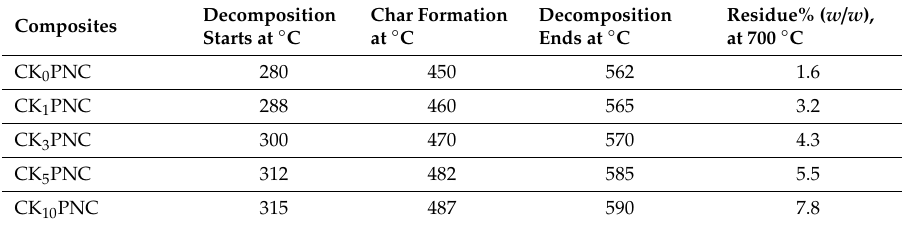
Table 2. Thermogravimetric profile of pure PMMA and composite films recorded from thermographs. Decomposition Char Formation Decomposition Residue% ( w / w ), Composites Starts at ◦ C at ◦ C Ends at ◦ C at 700 ◦ C